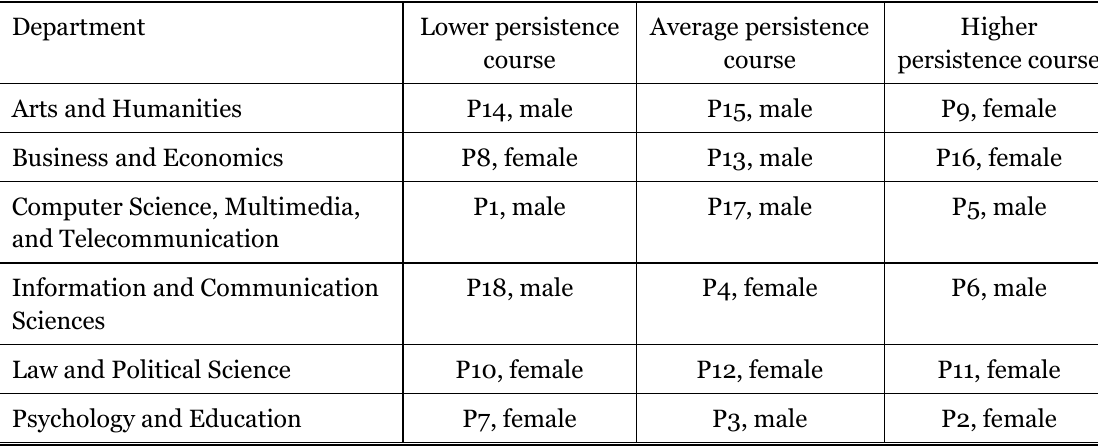
Distribution of Participants According to Selection